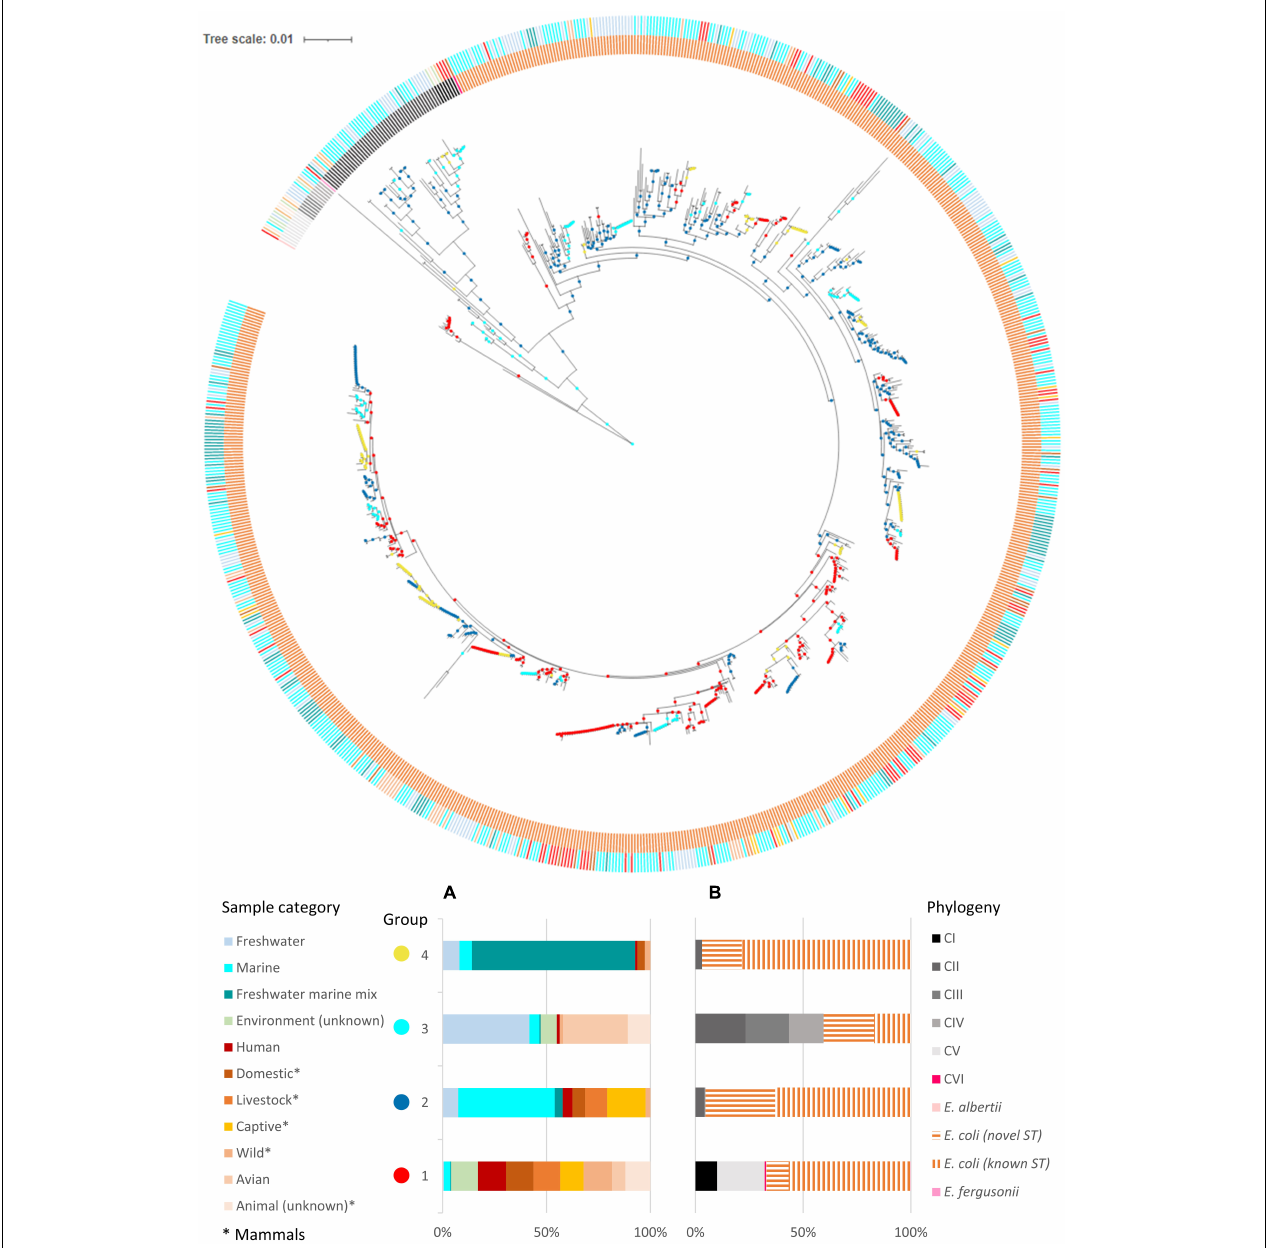
FIGURE 2 | Inferred habitat associations of ecologically distinct groups of Escherichia . Metadata were mapped onto the ML tree built using concatenated sequences of seven MLST loci (general time reversible G + I model, 500 bootstrap replications). The outer ring indicated the sample category of the isolates while the inner ring indicated their phylogeny. Inferred ecologically distinct groups are shown as colored circles at the nodes. (A) Inferred ecologically distinct groups, defined by distinct distributions of isolates over the sample sources. (B) Distribution of phylogeny for each inferred group. All distributions are normalized by the total counts in each sample source to account for uneven sampling across sample